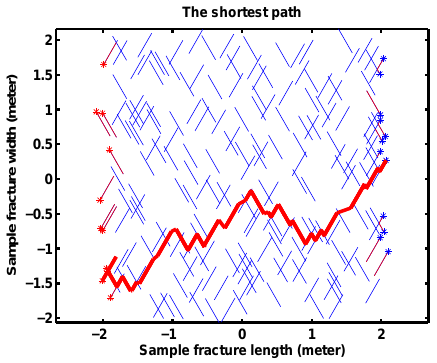
Figure 9. The hydraulic fracture of the discrete fracture